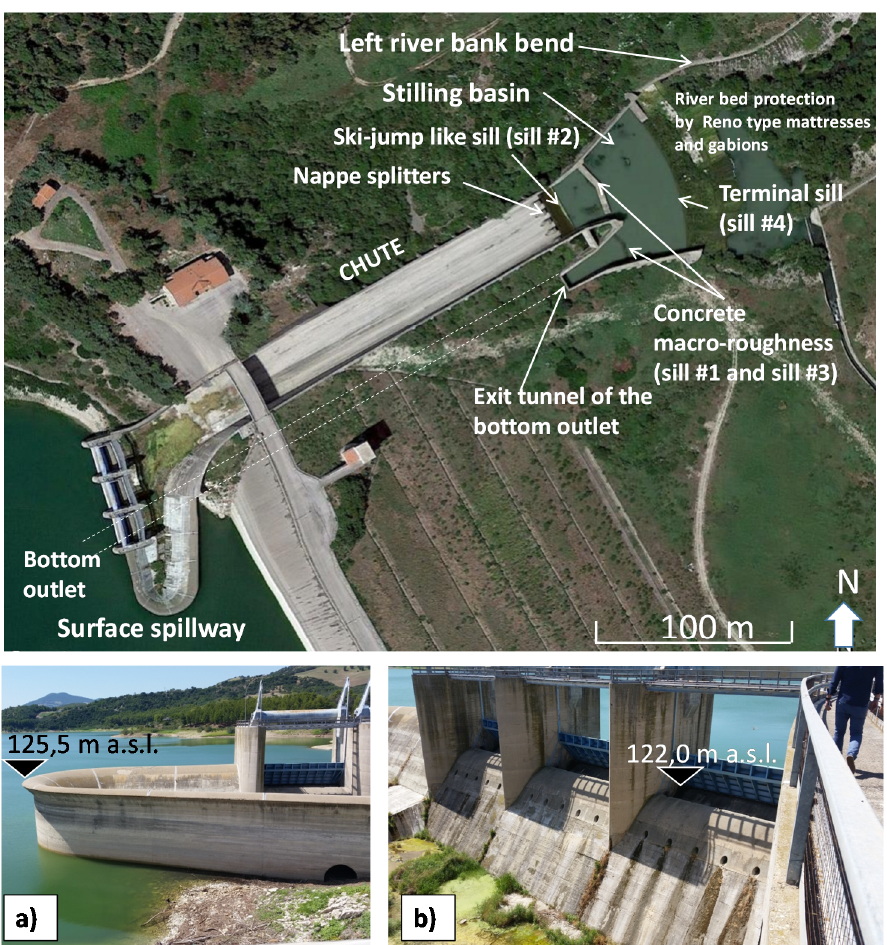
Figure 2. Upper panel: surface spillway, bottom outlet components and dissipating structures. Lower panel: surface spillway: ( a ) ungated ogee weir (free Creager type sill); ( b ) gated weir with three 13 m wide openings, equipped with automatic flap gates.